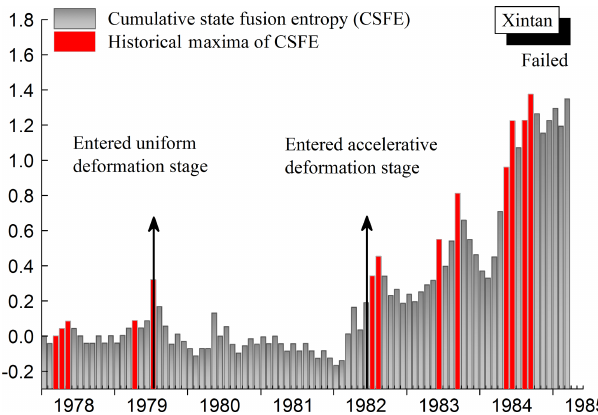
Figure 7. Cumulative state fusion entropy and historical maxima of Xintan